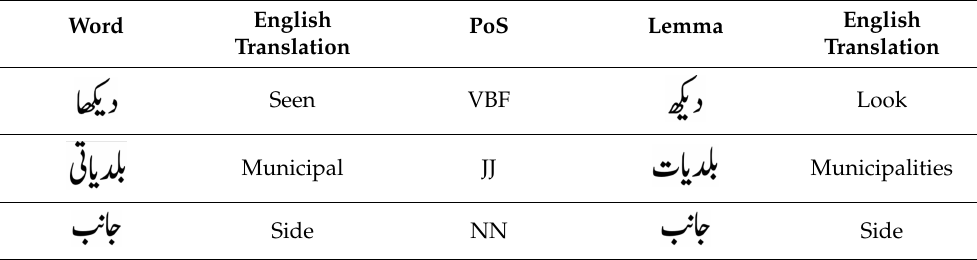
Table 3. Sample of the standard